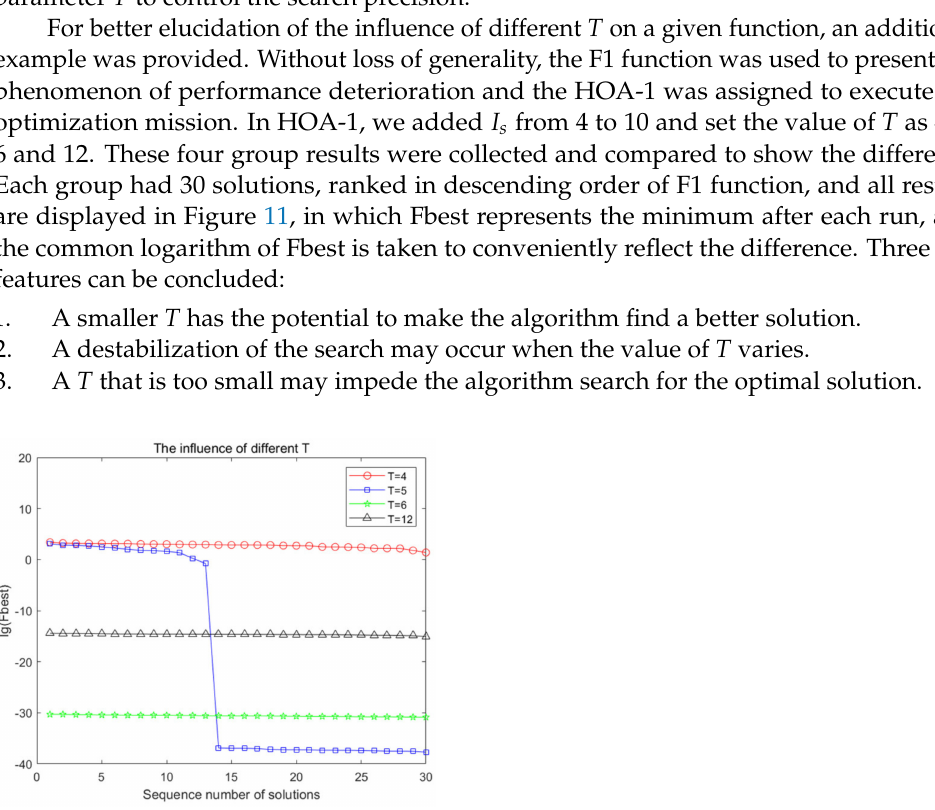
Figure 11. The influence of different values of T on optimized